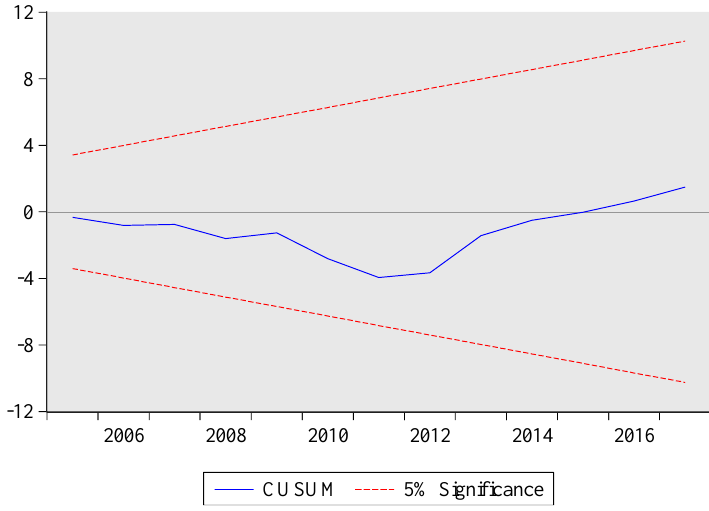
Figure 3. CUSUM test for Model 1. The plot of the cumulative sum of recursive residuals. Note: The red dashed lines represent the critical bounds at the five percent significance level. Int. J. Environ. Res. Public Health 2020 , 17 , x FOR PEER REVIEW